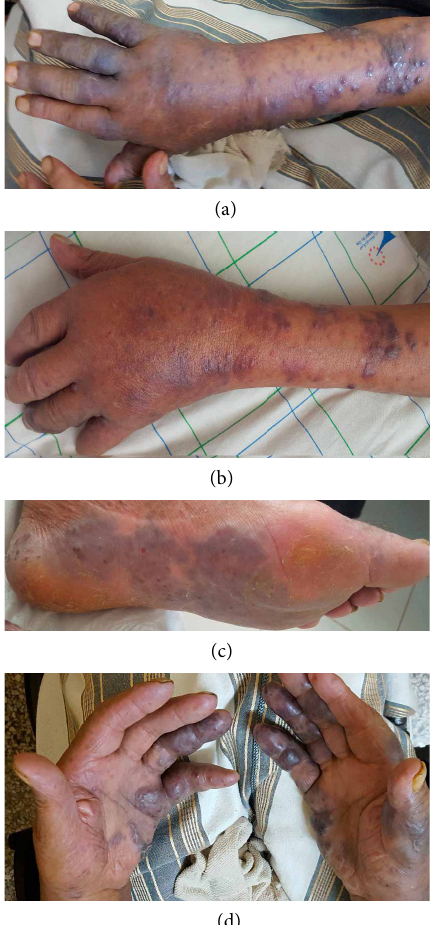
Figure 1: (a) Forearm cutaneous lesions. (b) Hand lesions extension. (c) Plantar cutaneous lesions. (d) Palmar cutaneous